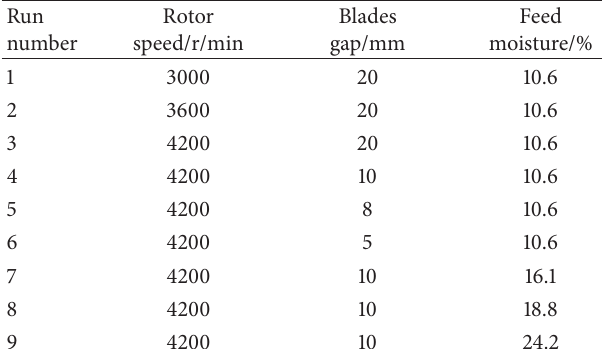
Table 2: Operation conditions of advanced